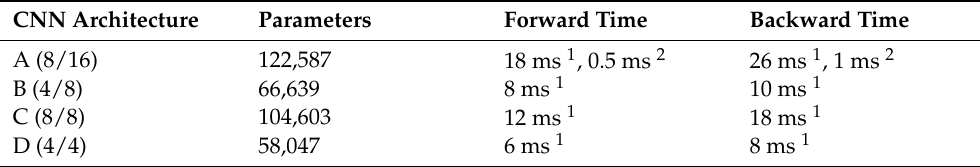
Table 2. Forward and backward (training) times for one 64 × 64 × 3 segment and different CNN